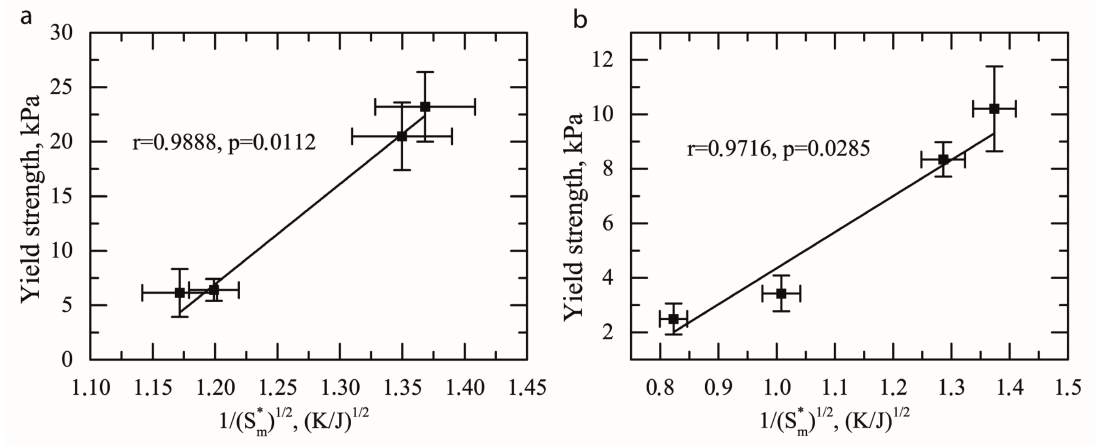
Figure 6. Relation between microstructure entropy ( S ∗ m ) and yield strength ( E ) for beeswax ( a ) and beeswax hydrocarbons ( b )